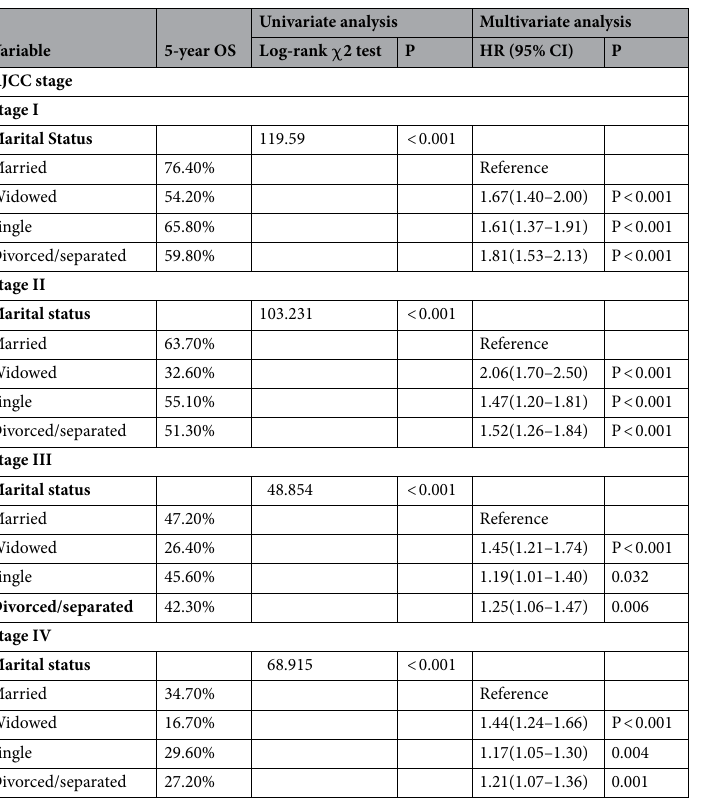
Table 4. Univariate and multivariate analysis of the effect of marital status on laryngeal cancer OS based on different cancer stages before PSM. OS, overall survival; PSM, propensity score matching; HR, hazard ratio; CI, confidence